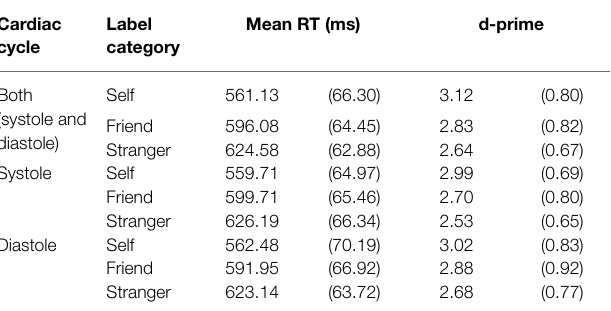
TABLE 1 | Mean reaction time (RT) and d-prime as a function of label category and cardiac cycle. Cardiac